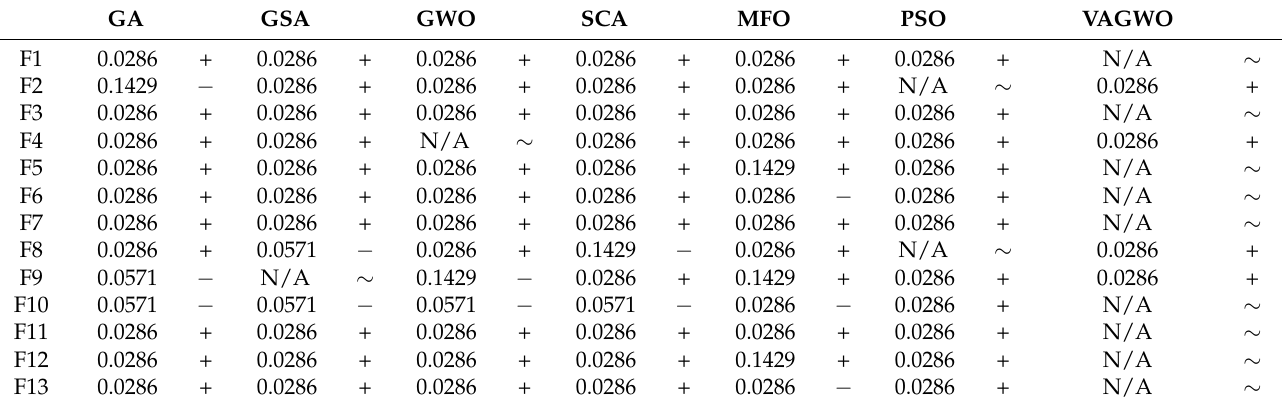
Table 9. p -values and signs of the Wilcoxon test for VAGWO against the popular algorithms on the standard functions.